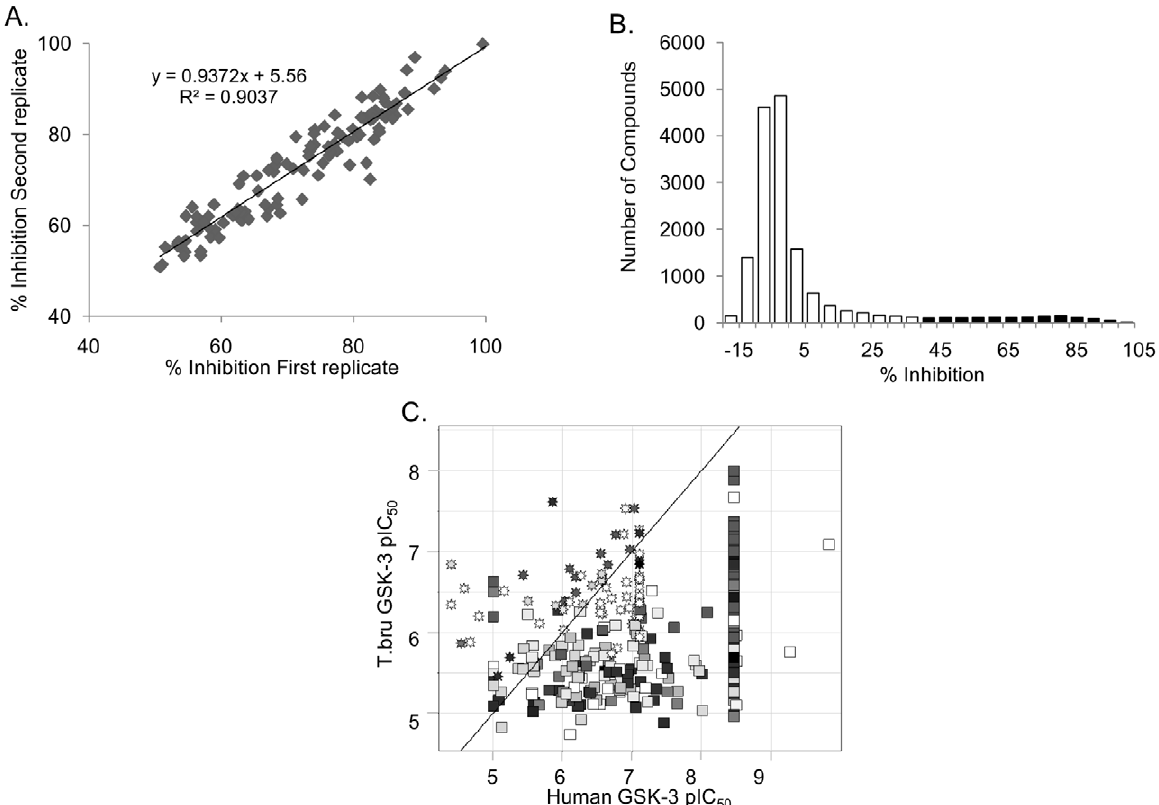
Figure 1. Screening results. (A) Verification of data reproducibility generated from duplicate testing of 5 separate 384-well plates. (B) Histogram plot showing distribution of hit compounds (black bars). (C) Plot of Tbru GSK-3 short pIC 50 against Hs GSK-3 pIC 50 revealing Tbru GSK-3 short selective compounds. Points are shaded by cluster ID and shaped by iteration, where squares are the original hits and stars are the near neighbours that were subsequently picked. pIC 50 is -log IC 50 where 9=1 nM and 6=1 m M.